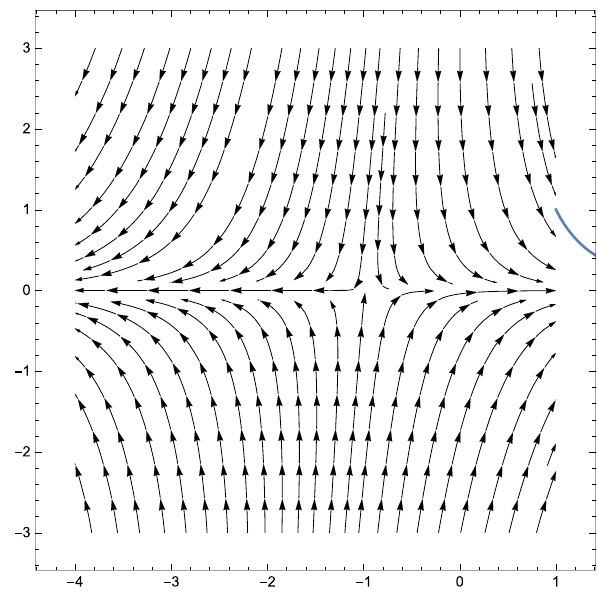
Fig. 3 The phase plot for F 1 at α 2 = 4 > 3 representing saddle , stable attractor 3